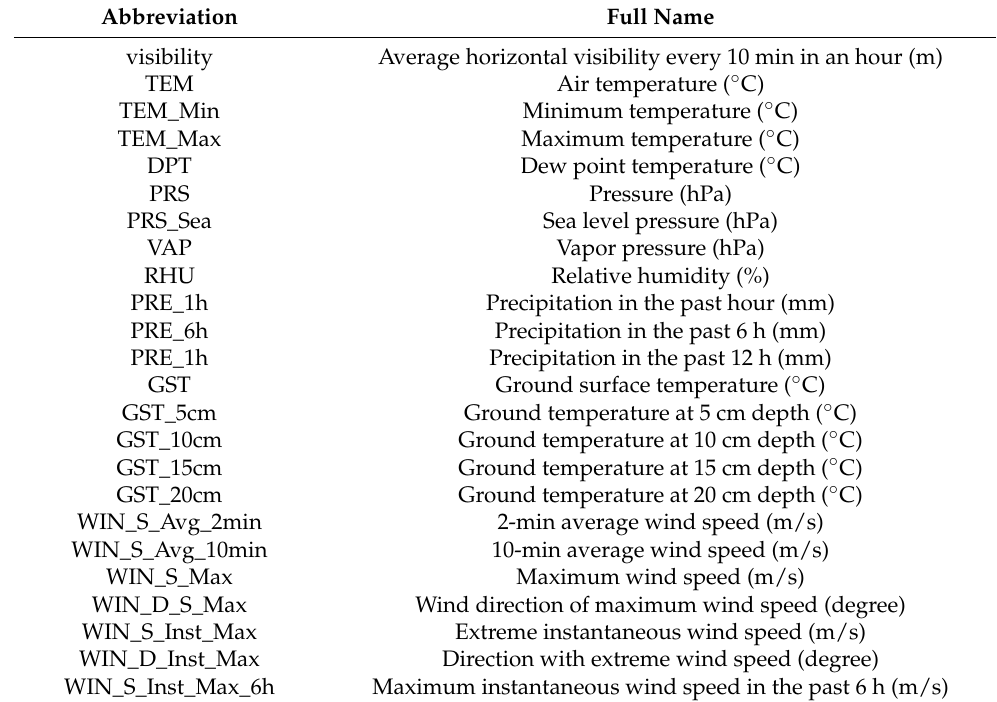
Table 2. Meteorological elements used in this